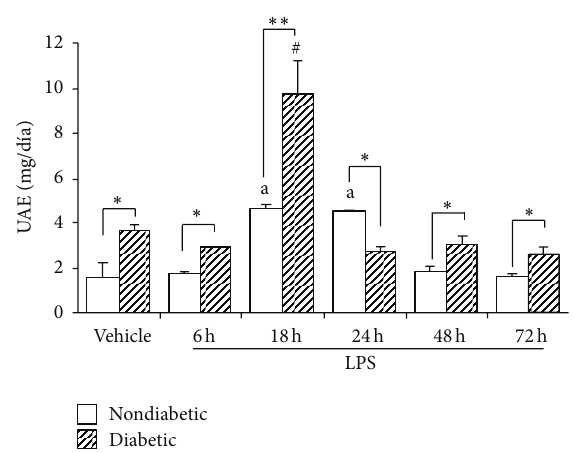
Figure 1: Urinary Albumin Excretion (UAE) in diabetic and nondiabetic LPS-injected mice. Values are mean ± SEM. ∗ 𝑃 < 0.05 versus control value, ∗∗ 𝑃 < 0.01 versus control value, # 𝑃 < 0.01 versus diabetic, and a 𝑃 < 0.01 versus nondiabetic.